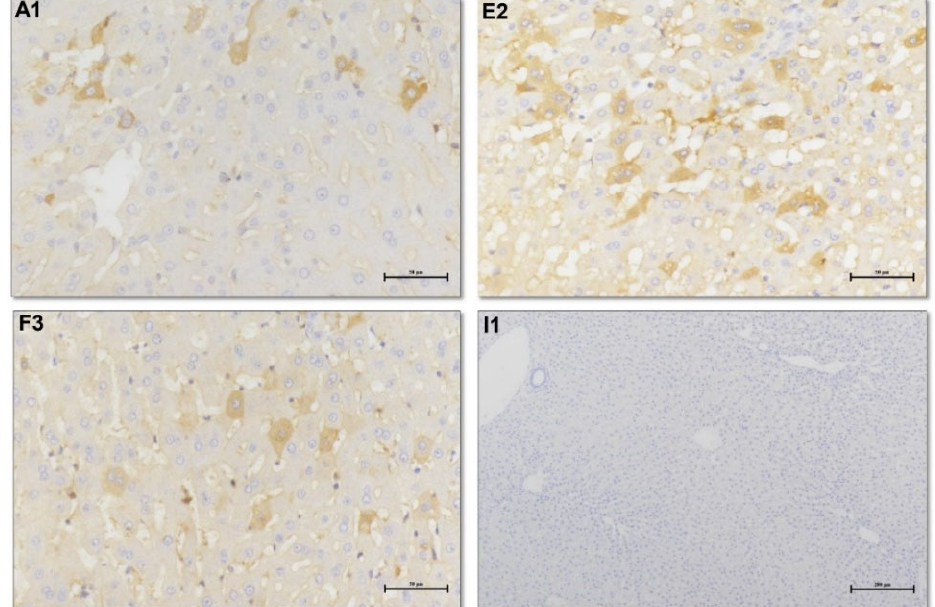
Figure 2. Immunohistochemistry analysis of HEV ORF2 proteins in rabbits’ liver tissues at 26 wpi. ( A1 , E2 , F3 ) represents the liver tissues of three individual rabbits with chronic infection of HEV. ( I1 ) is the liver tissue of the control rabbit in which the HEV infection was cleared within 8 weeks, but was kept in the study until 26 wpi.